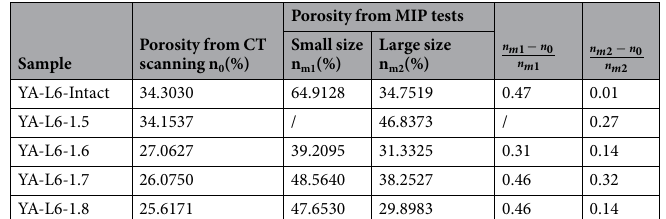
Table 1. Porosity of the samples from different tests. n —the ratio of the number of pore voxels to the number 0 —the ratio of total pore volume (cm 3 ) to the bulk sample volume (cm 3 ) of the of all voxels from CT scanning. n m 1 —the ratio of total pore volume (cm 3 ) to the bulk sample volume (cm 3 ) of small size sample from MIP test. n m 2 the large size sample from MIP test.